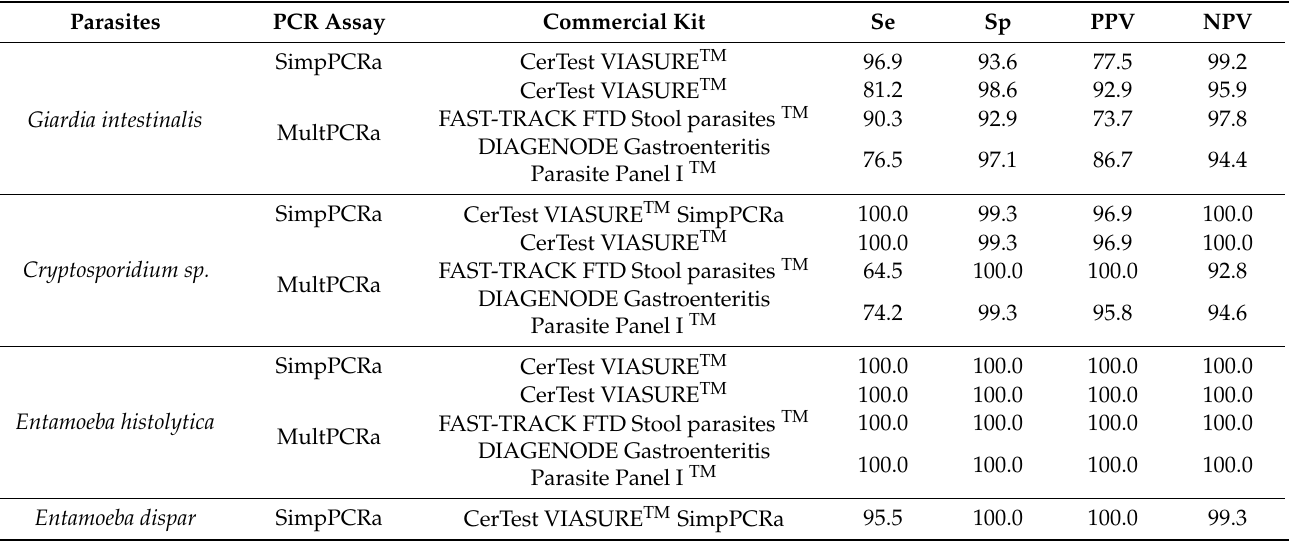
Table 4. Performances of the commercial simplex and multiplex PCR assays taking the Dijon University Hospital in-house simplex PCR assays as gold standard ( n = 173